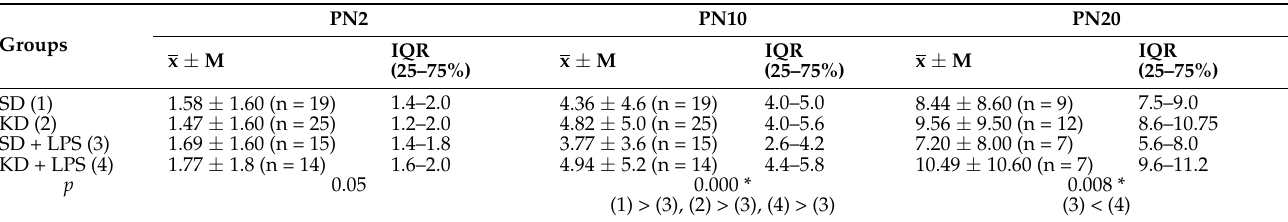
Table 5. Body weights (g) in the offspring.